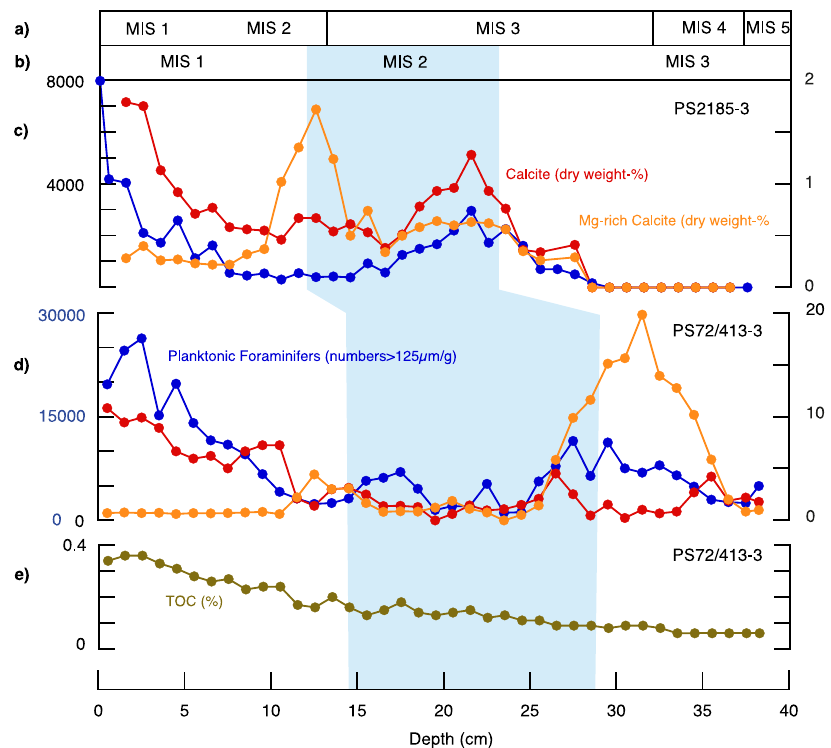
Fig. 8 Chronostratigraphy and sediment characteristics cores PS72/413-3 and PS2185-3 66 . a Published stratigraphy of core PS2185-3. b Chronostratigraphic interpretation based on 14 C ages of PI_2, non-calibrated and without reservoir correction (see Fig. 6b, e). c , d Relative abundance of carbonates quanti fi ed from X-ray diffraction analyses of bulk sediments 100 , and planktonic foraminifera numbers for cores c 2185-3 66 and d PS72/413-3 94 . e Total organic carbon PS72/413-3.